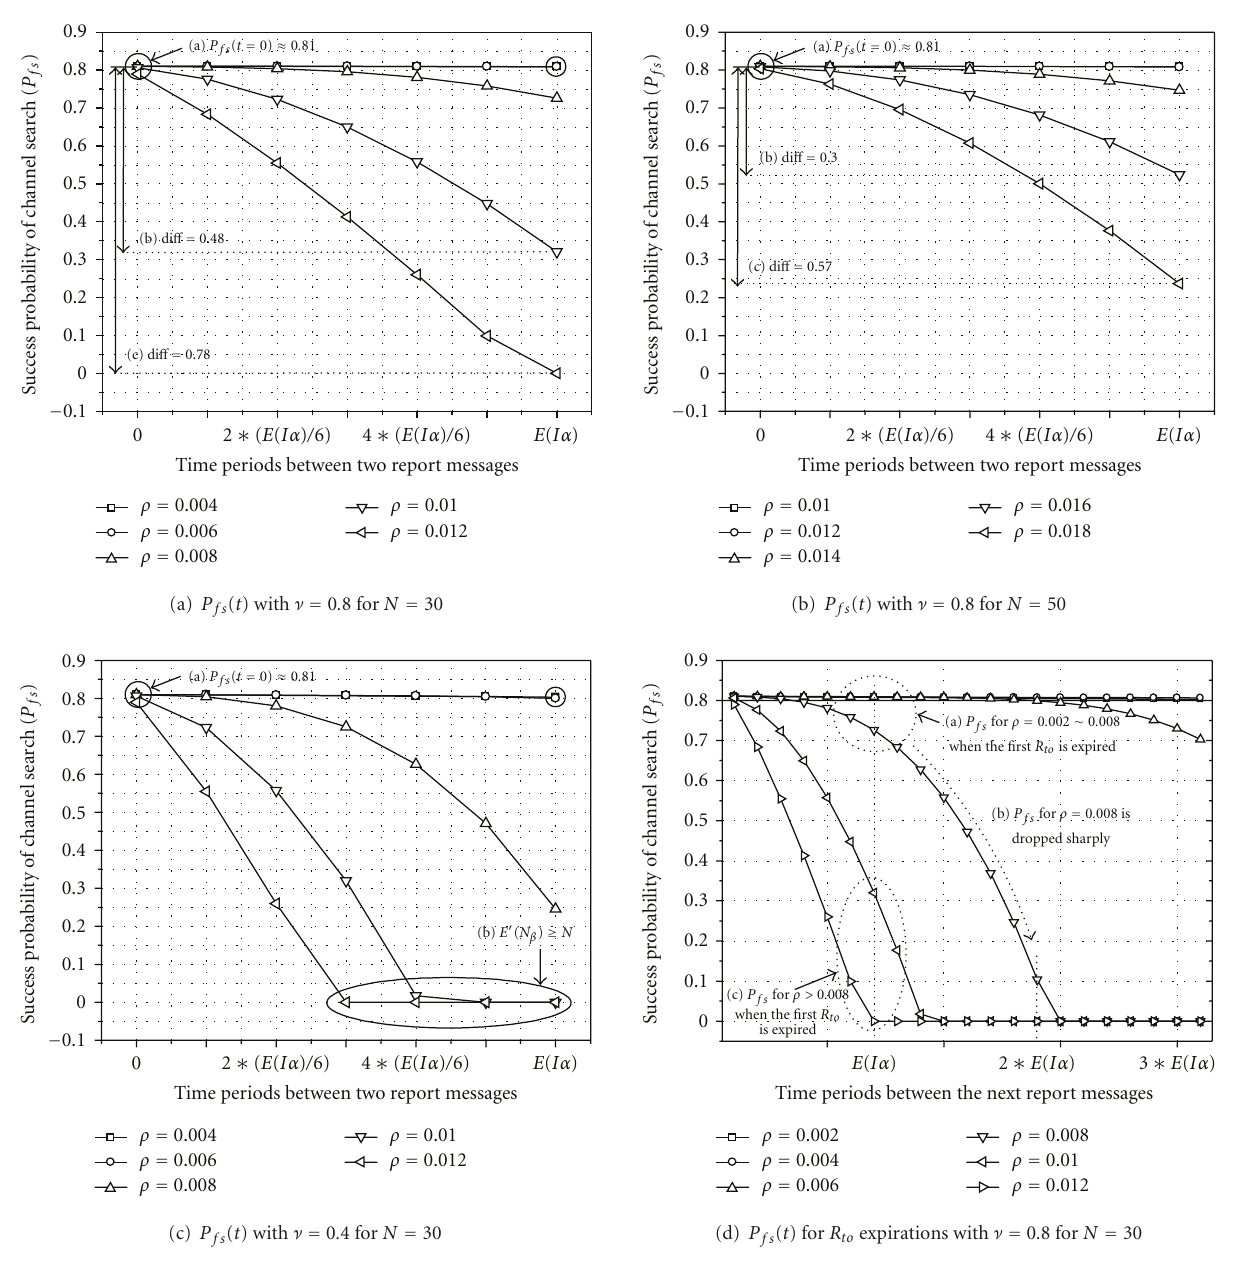
Figure 6: With the spectrum sensing reliability index, R s = 0 . 9, the analysis results of the expected probability of success in the first spectrum sensing, P fs ( t ), with R = 120m and N = 30 in (a) and (c) are presented. In subfigure (b), for N = 50, ρ varies from 0.010 to 0.018. Subfigure (a) and (b) indicate that a higher ρ contributes to the drastic drop of the probability of success, which we observe in (c) labels of subfigure (a) and (b). In subfigure (c), with a lower ν = 0 . 4, P fs still approaches 80 % for ρ = 0 . 004 and ρ = 0 . 006. A subfigure (d) indicates the extent to which P fs will decrease if we have consecutive expiration of R to